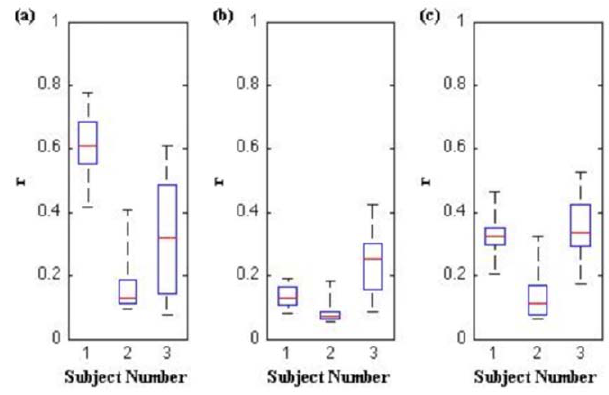
Figure 6. Correlation coefficients between (a) LR and FB (b) LR and UD, and (c) FB and UD control signals at zero lag. Calculations were made for each five-minute session.